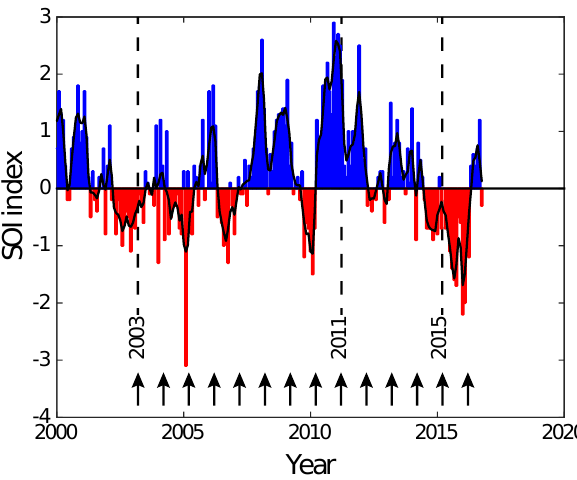
Figure 4. Time series of the monthly Southern Oscillation Index (SOI) from January 2000 to October 2016. Negative and positive values are shaded red and blue to signify El Niño and La Niña, respectively. SOI smoothed by a lowess filter with a five-point win- dow is shown as a solid black line. Black arrows indicate March for the years when satellite data are available. Dashed vertical lines indicate March 2003, 2011, and